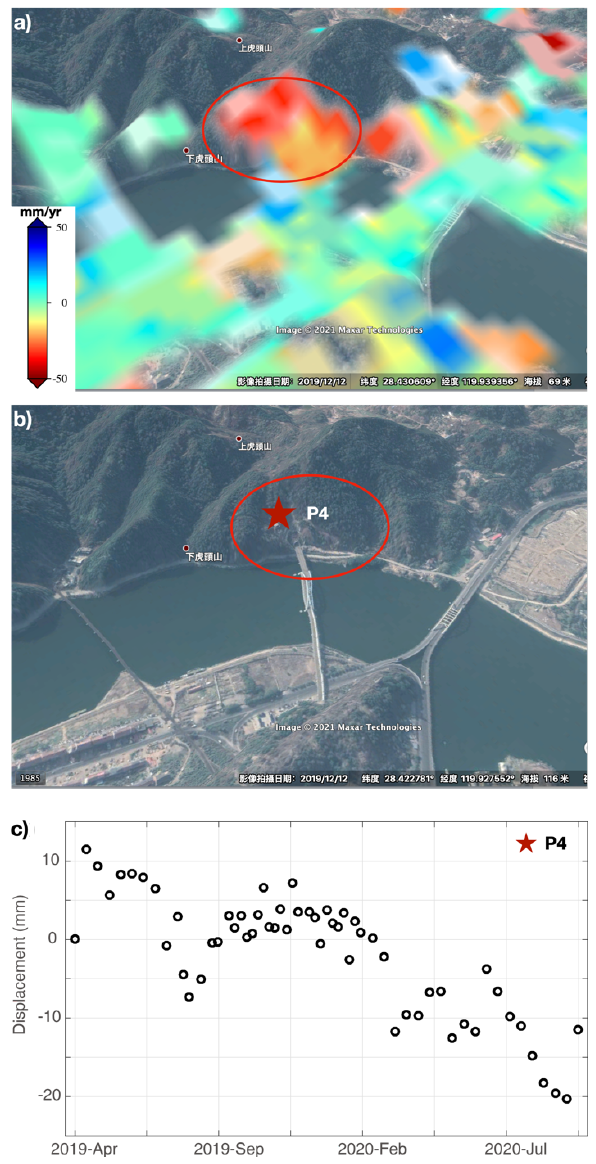
Figure 9 . (a) Subsidence velocities of a mountain crossing tunnel. (b) is the corresponding Google Earth TM image of (a). (c) Time-series displacement of P4 in the tunnel entrance.